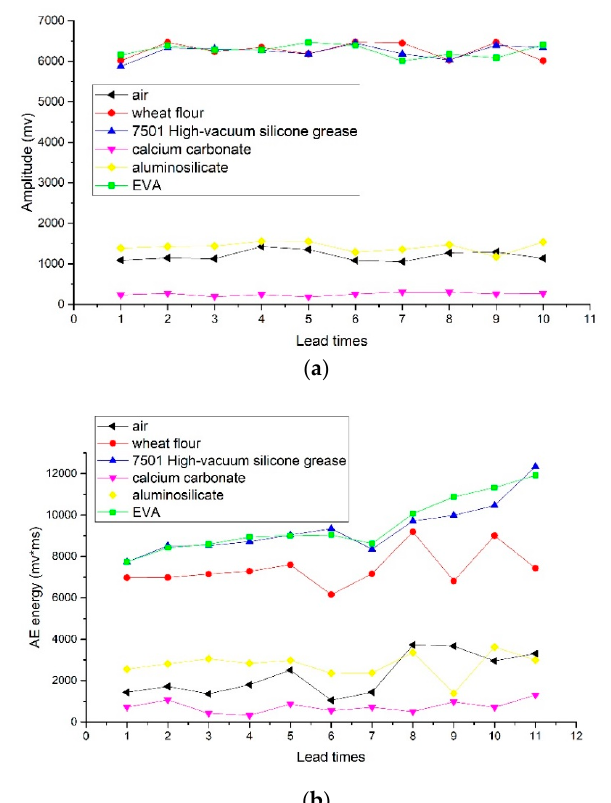
Figure 4. amplitude and energy of acoustic emission signals with six different materials as couplant. Figure 4. Amplitude and energy of acoustic emission signals with six di ff erent materials as